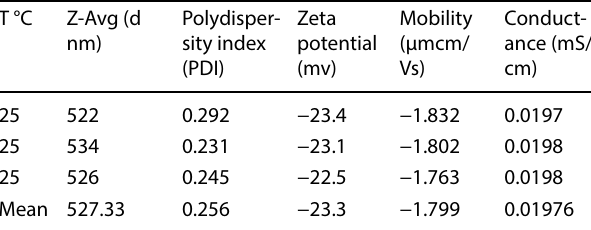
Table 4 Zeta potential and dynamic light scattering measurements